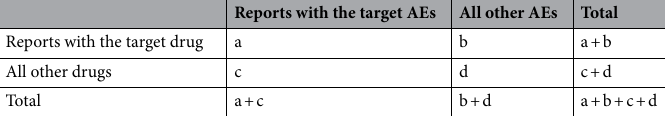
Table 7. Two-by-two contingency table for disproportionality analyses.